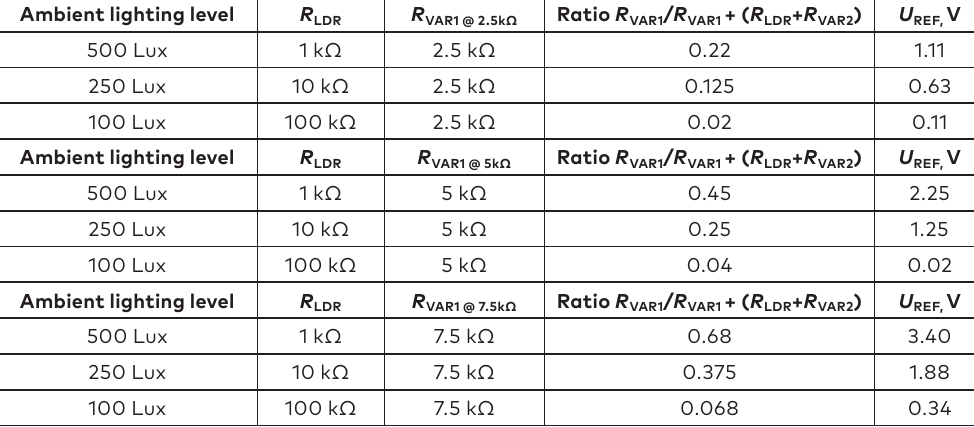
Table 2. Example of calculated sensitivity of reference voltage